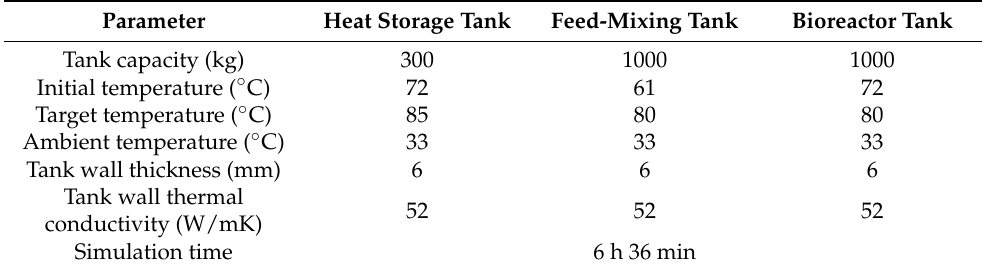
Table 1. Operating parameters of the tanks in the validation model.